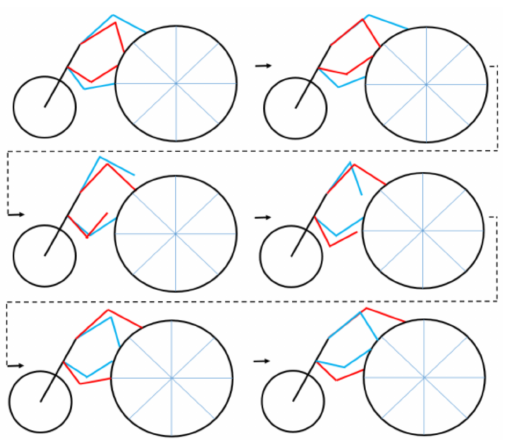
Figure 10. The gait pattern of the robot in ball rolling motion. Red line: Legs at robot’s right side; Blue line: Legs at robot’s left